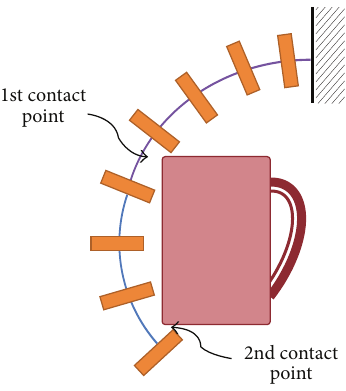
Figure 2: Object grasping by two contact points.